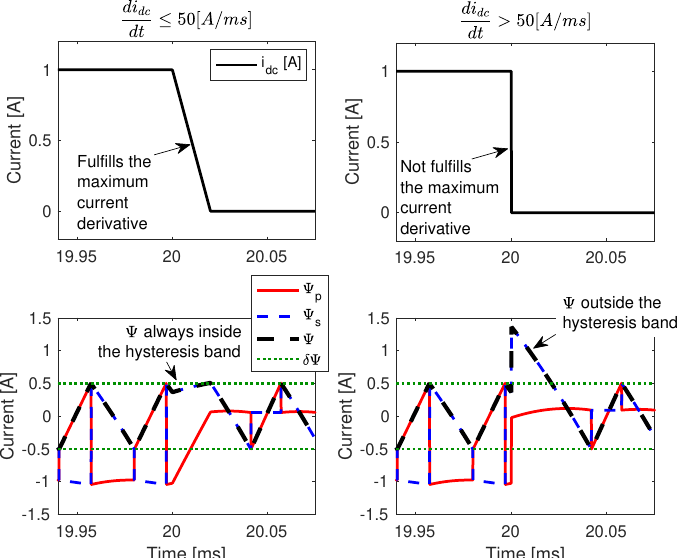
Figure 12. Reachability of the hysteresis band. Left: reachability from Ψ > + δ Ψ ; Right: reachability from Ψ < − δ Ψ .